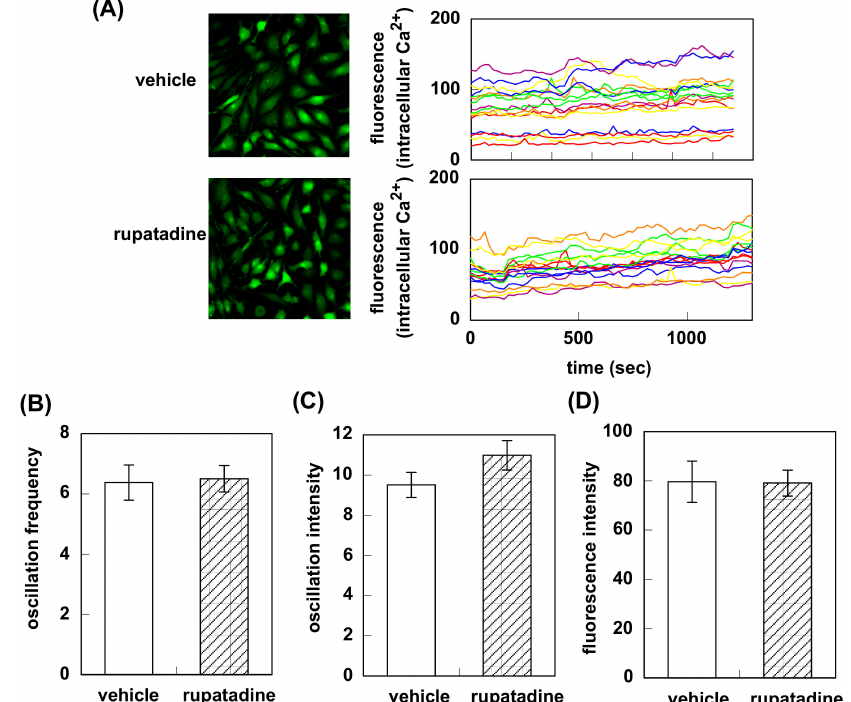
Figure 3. E ff ect of rupatadine on intracellular Ca 2 + elevation in response to the constitutive activation of histamine H 1 receptor. ( A ) HeLa cells were treated with 10 µ M of rupatadine for 2 h at 37 ◦ C and intracellular Ca 2 + was monitored for 20 min at 22 sec intervals. In ( B ) to ( C ), oscillation frequency ( B ), oscillation intensity ( C ), and fluorescence intensity ( D ) for 20 min were counted. Data are expressed as means ± SEM ( n =